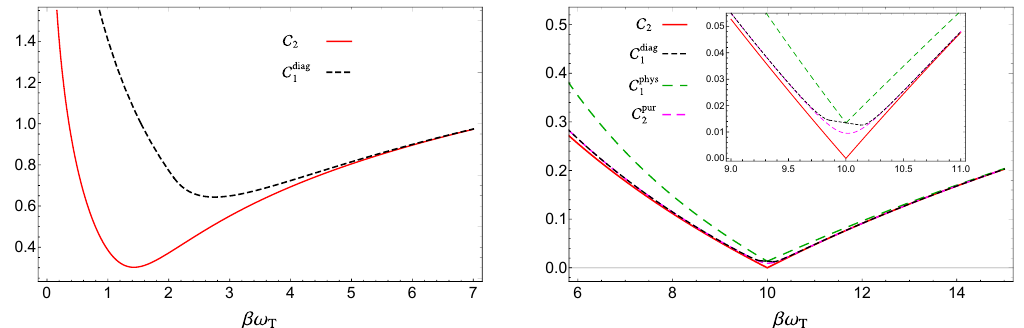
Figure 12 . One-mode mixed states: The complexity C 2 from (9.83) (red solid line) and the complexities C 1 and C pur based on the purification complexity, as functions of βω . The complexity T 2 C 1 is evaluated for the diagonal basis from (9.84) (black dashed line) and for the physical basis from (9.85) (green dashed line). The complexity C pur from (9.86) is independent on the basis 2 (magenta dashed line). In the left panel βω = 1 , while in the right panel βω = 10 , hence also R R C phys and C pur are 1 2